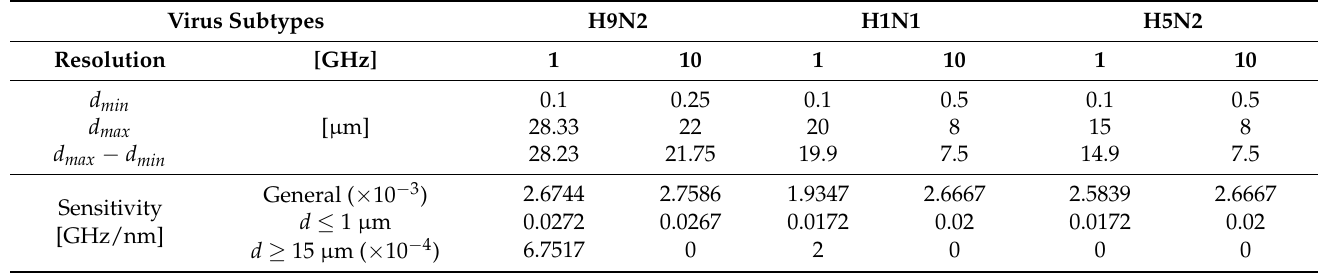
Table 3. Numerical representation of sensitivity parameters around the first peak for SquarePMA.